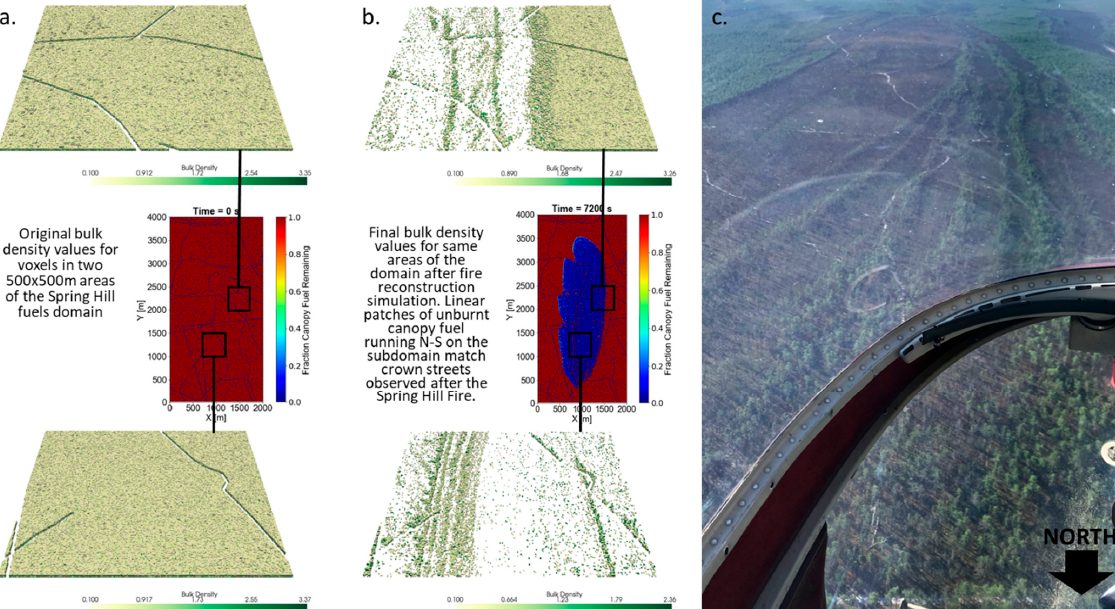
Figure A1. Tree crown streets, or long linear patterns of unburnt trees, were produced by the Spring Hill Fire reconstruction: ( a , b ) closely matched those observed following the actual fire ( c ). 3D renderings of QUIC-Fire outputs were created using the Python Pyvista library [50].